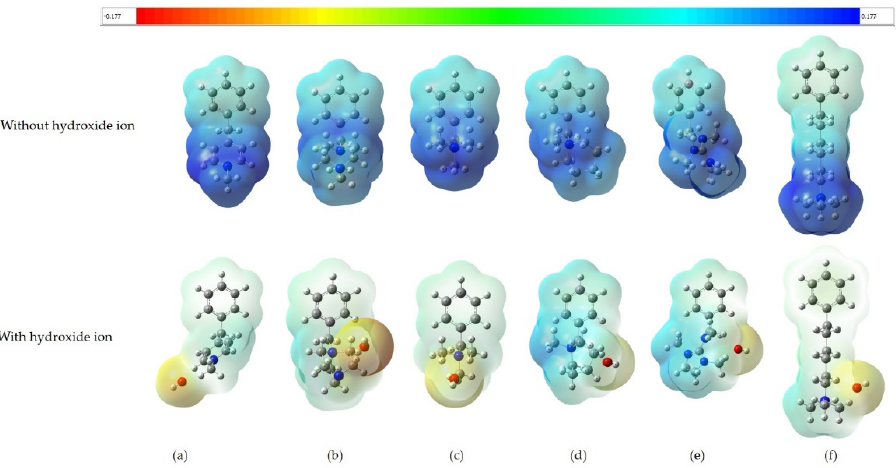
Figure 3. Representation of molecular electrostatic potential maps for QA head groups ( a – f ) and their complexes with hydroxide ions in the presence of implicit water. Surface |Isovalue| = 0.02 a.u. Value range [ − 0.177; 0.177] a.u. Legend of colors: red (negative) to blue (positive).